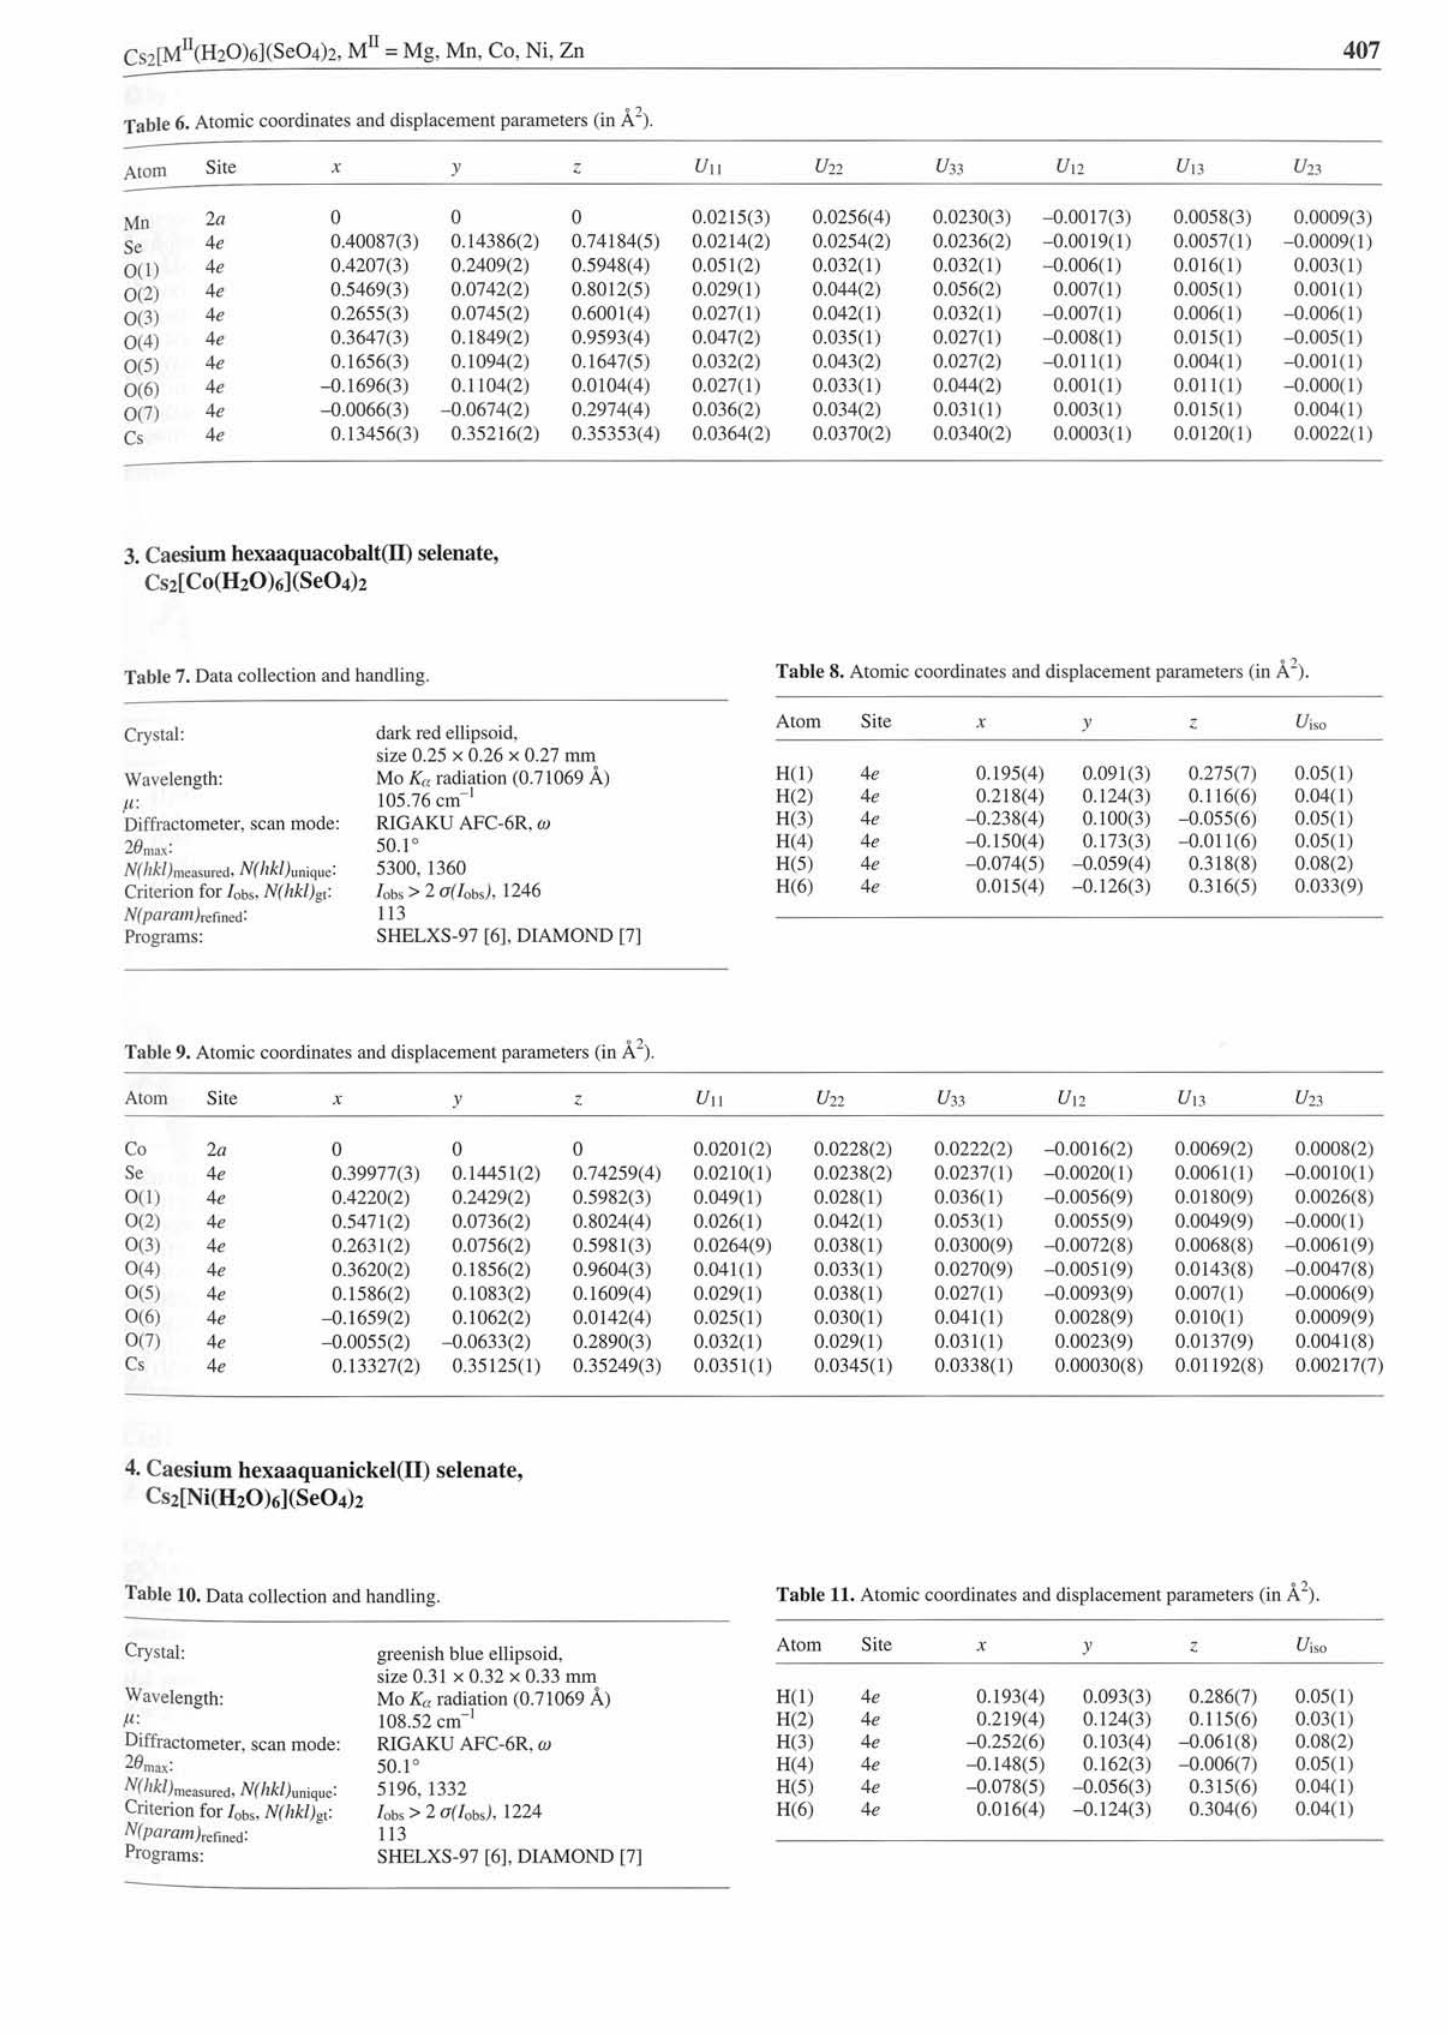
Table 10. Data collection and handling. Table 11. Atomic coordinates and displacement parameters (in A 2